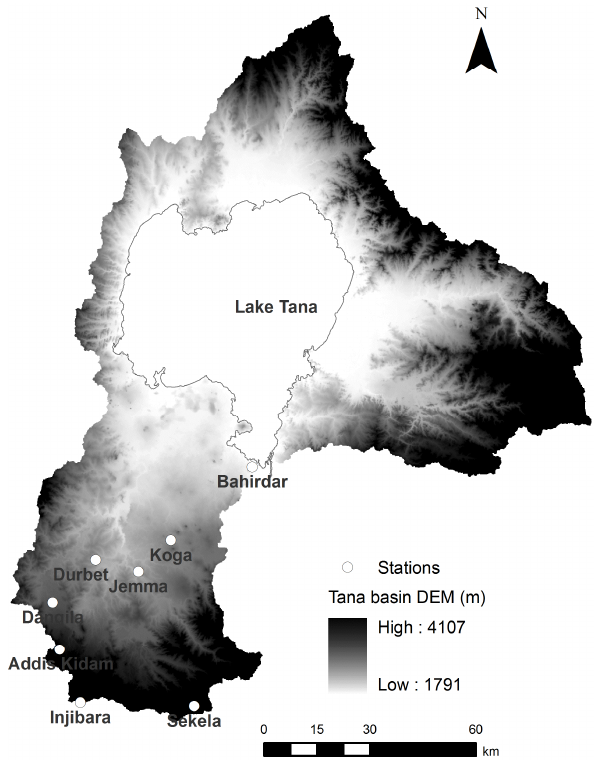
Fig. 1. The Lake Tana basin area and the location of the rain gauge Fig. 1 The Lake Tana basin area and the location of the rain gauge stations . 732